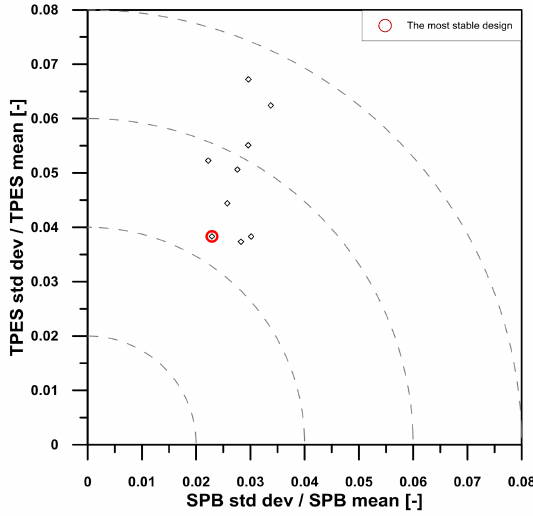
Figure 12. Pareto dominant solutions obtained through the second robust design